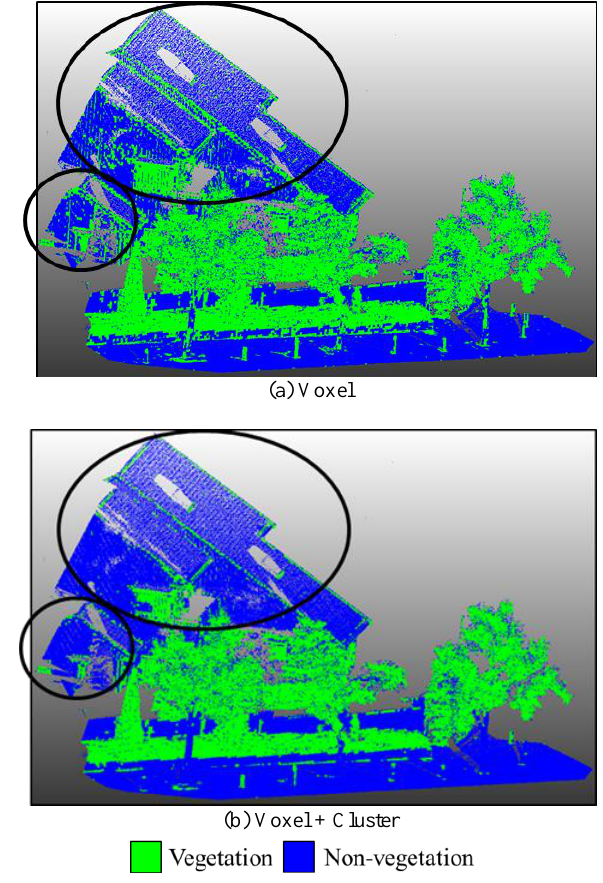
Figure 7. Effect of combination of local and contextual features. (a) Result only using voxel-based analysis and (b) result using voxel-based and cluster-based analysis.